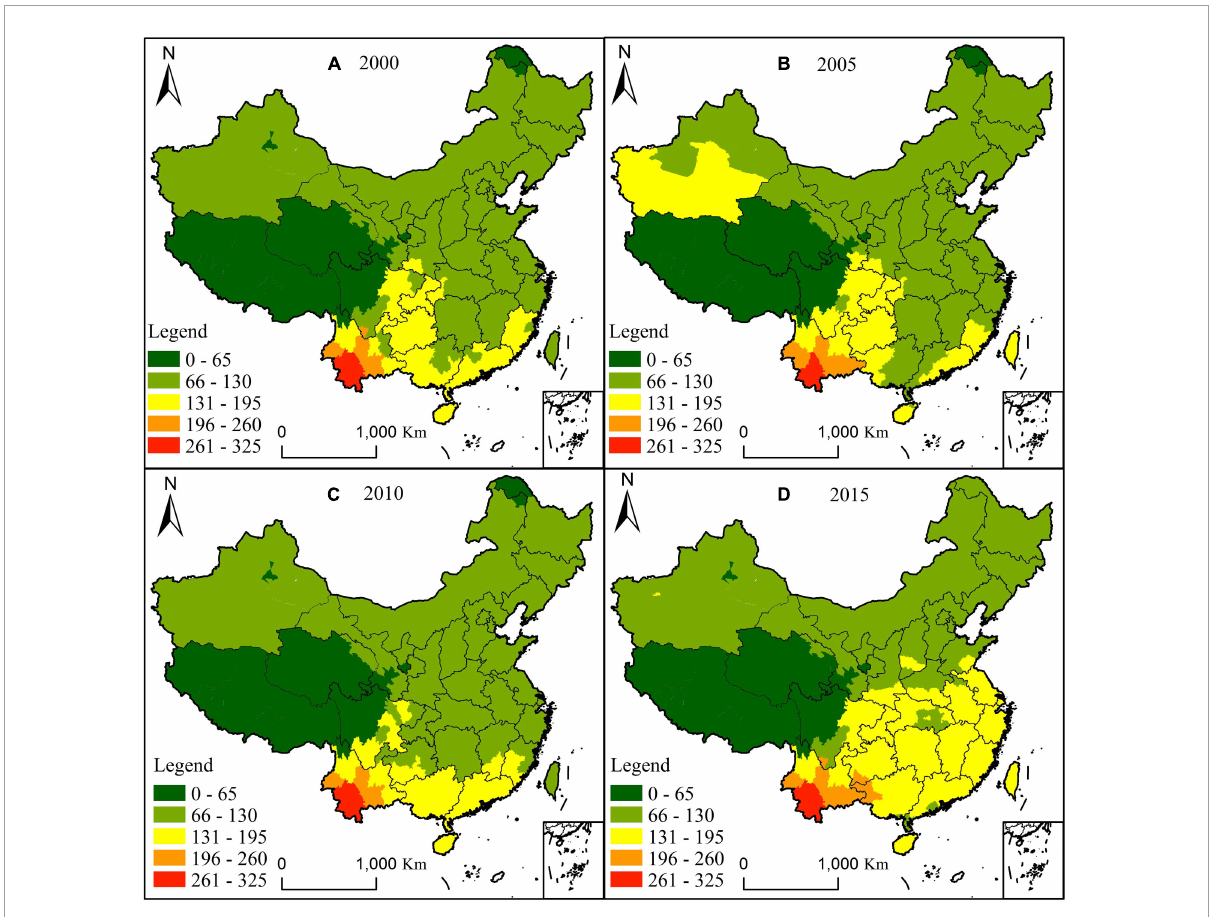
FIGURE4 Daily change in human settlement climate comfort in China from 2000 to 2015.